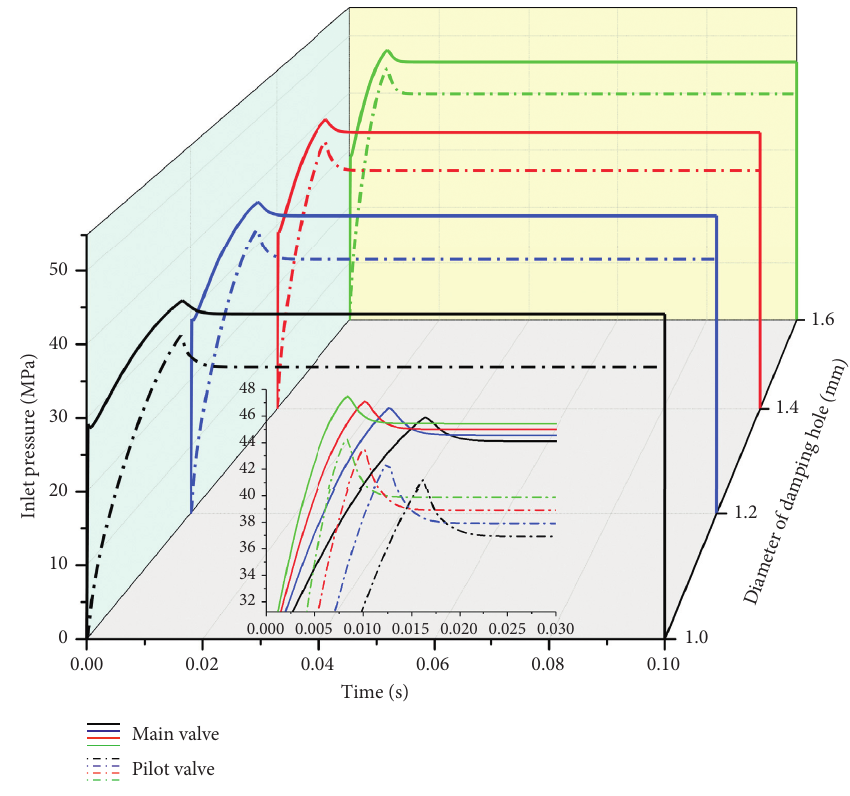
Figure 16: Influence of damping holes diameter.